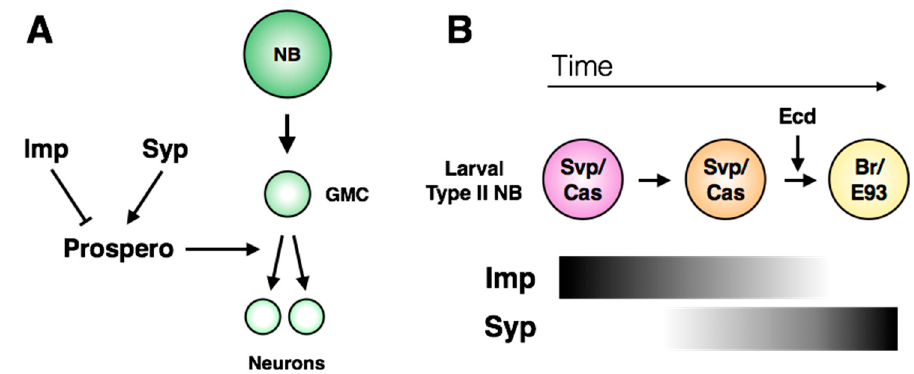
Figure 8. Regulation of neuroblast terminal division. ( A ) The RNA-binding proteins Imp and Syp have opposing effects on Prospero-mediated terminal division. Imp is sufficient to prevent cell cycle exit, but Syp may play an indirect permissive role for Prospero function. ( B ) Imp and Syp expression correlates to progression of the larval temporal series. Imp expression is down-regulated following the pulse of ecdysone, but Syp expression begins prior to this pulse.